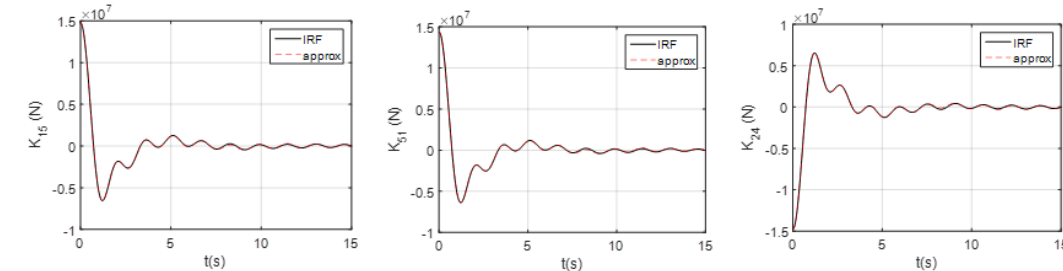
Figure 11. The strong coupled terms of impulse functions.